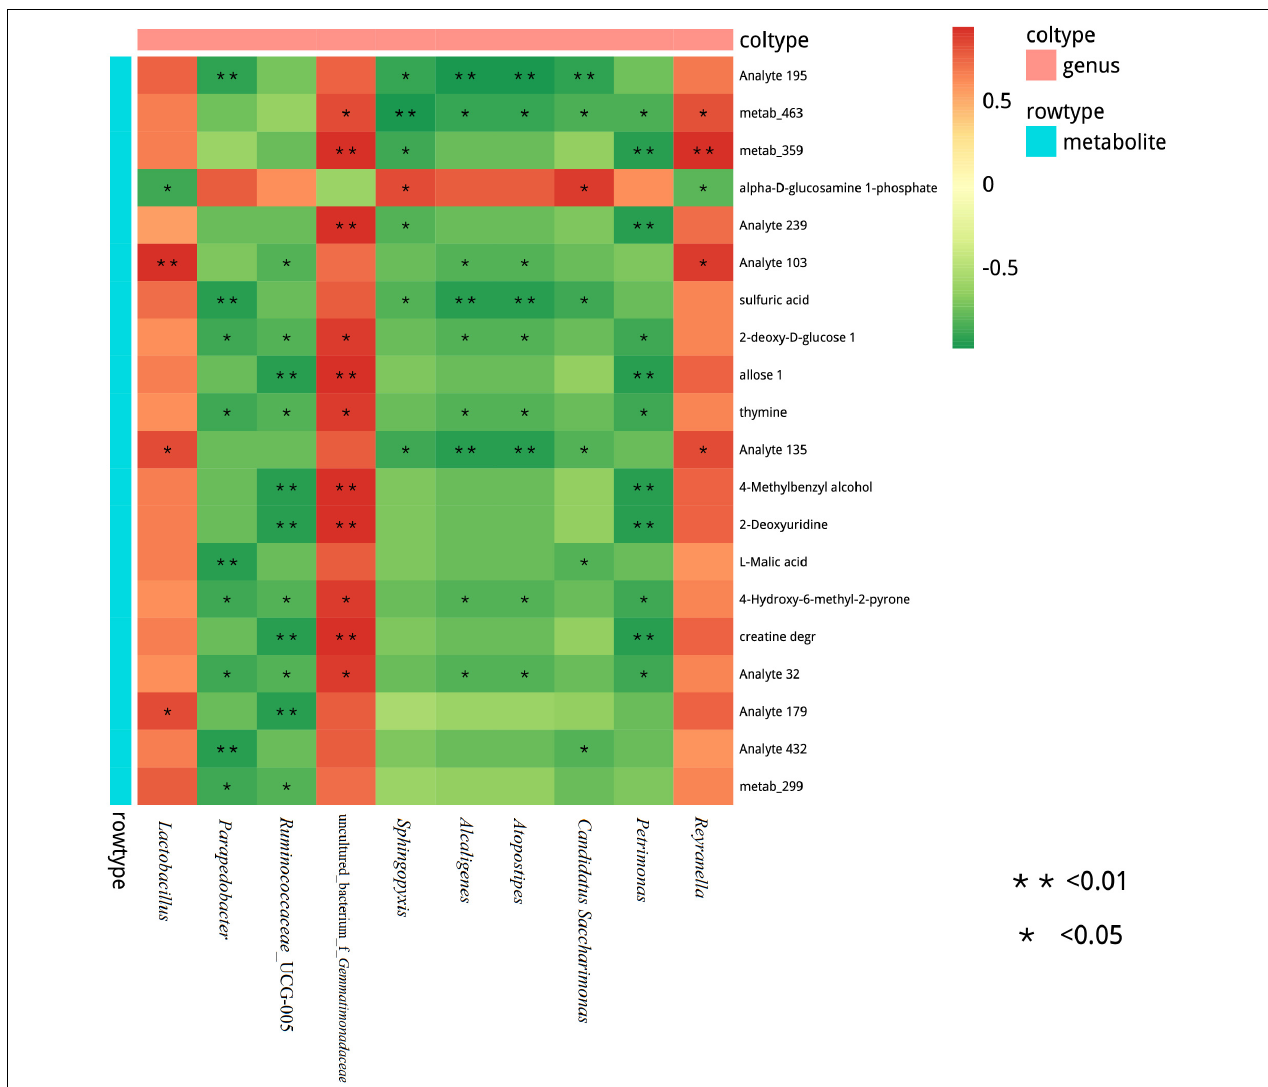
FIGURE 7 | Correlation matrix between the silage differential metabolites affected by the melatonin and the differential microbiota at the genus level. Positive correlations are shown in red, and negative correlations are indicated in green. Color intensity is proportional to the correlation values (r). P -values are shown as *0.01 < P ≤ 0.05, ** P ≤